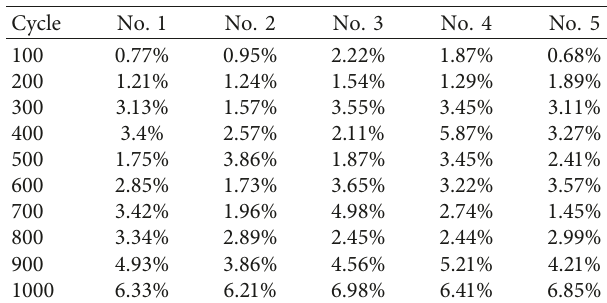
Figure 6: Capacity estimation errors of five batteries based on proposed method. Table 2: Capacity estimation accuracy of the proposed